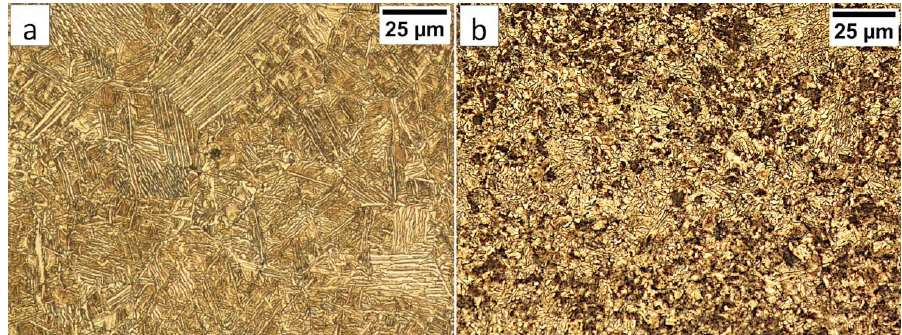
Figure 8. ( a ) The structure of the HTHAZ in the area “B” (marked in Figure 4). Lath morphology of bainite. ( b ) The structure of the HTHAZ in the area “C” (marked in Figure 4). Banite and pearlite. Etched by nital, LM.